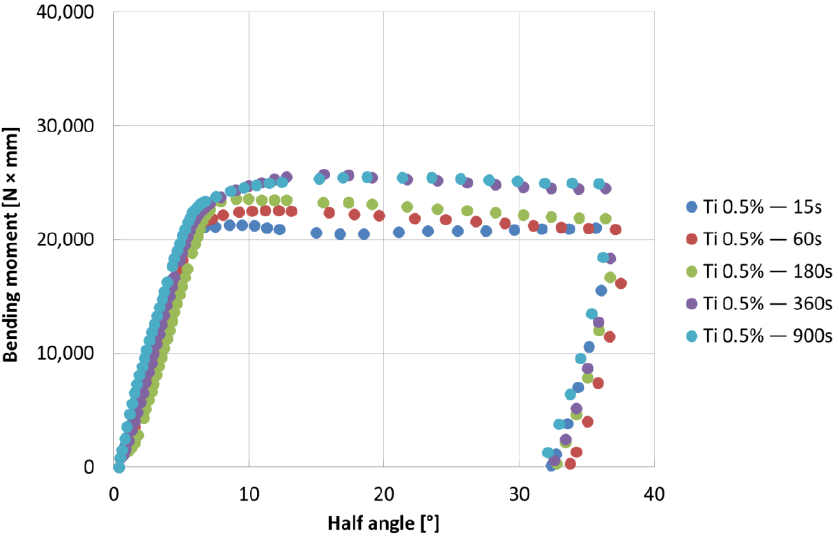
Figure 5. Bending tests results for specimens from Zn-Ti 0.5% bath.